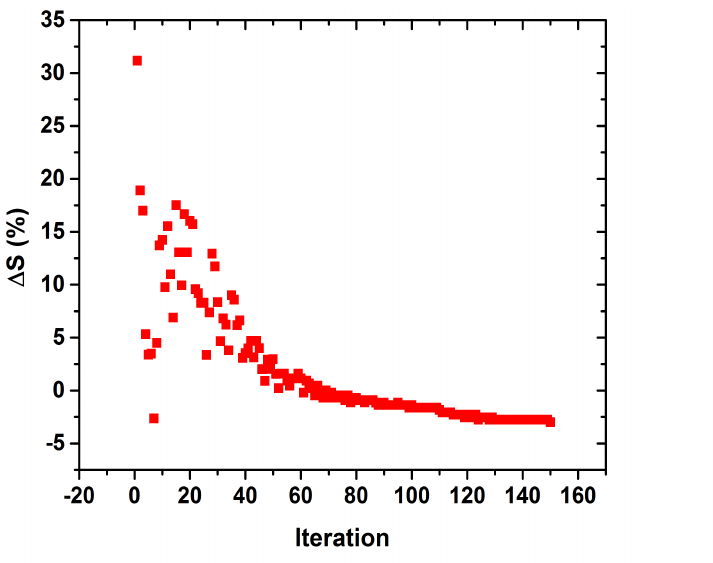
Figure 12. Percentage difference of distance of particles ( ∆ l ) with diameter of 800 nm from the desired trajectory between inlet velocity 0.08 m/s and 0.06